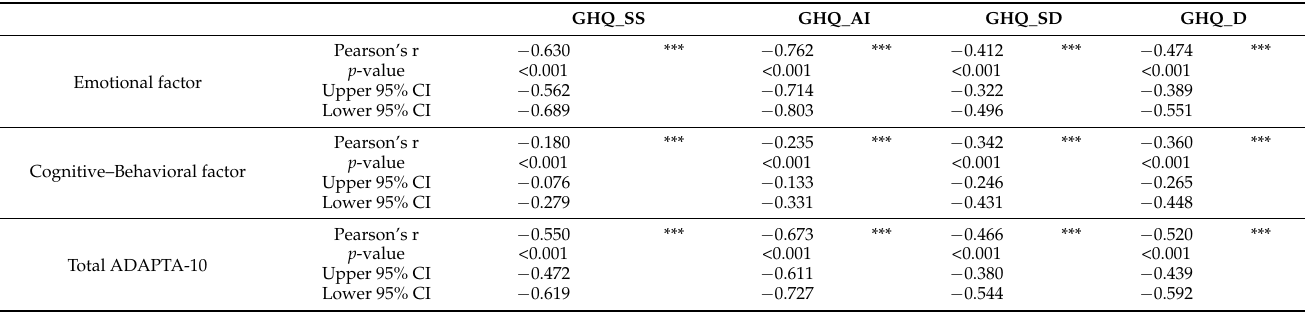
Table 1. Adaptability to change and health. Pearson